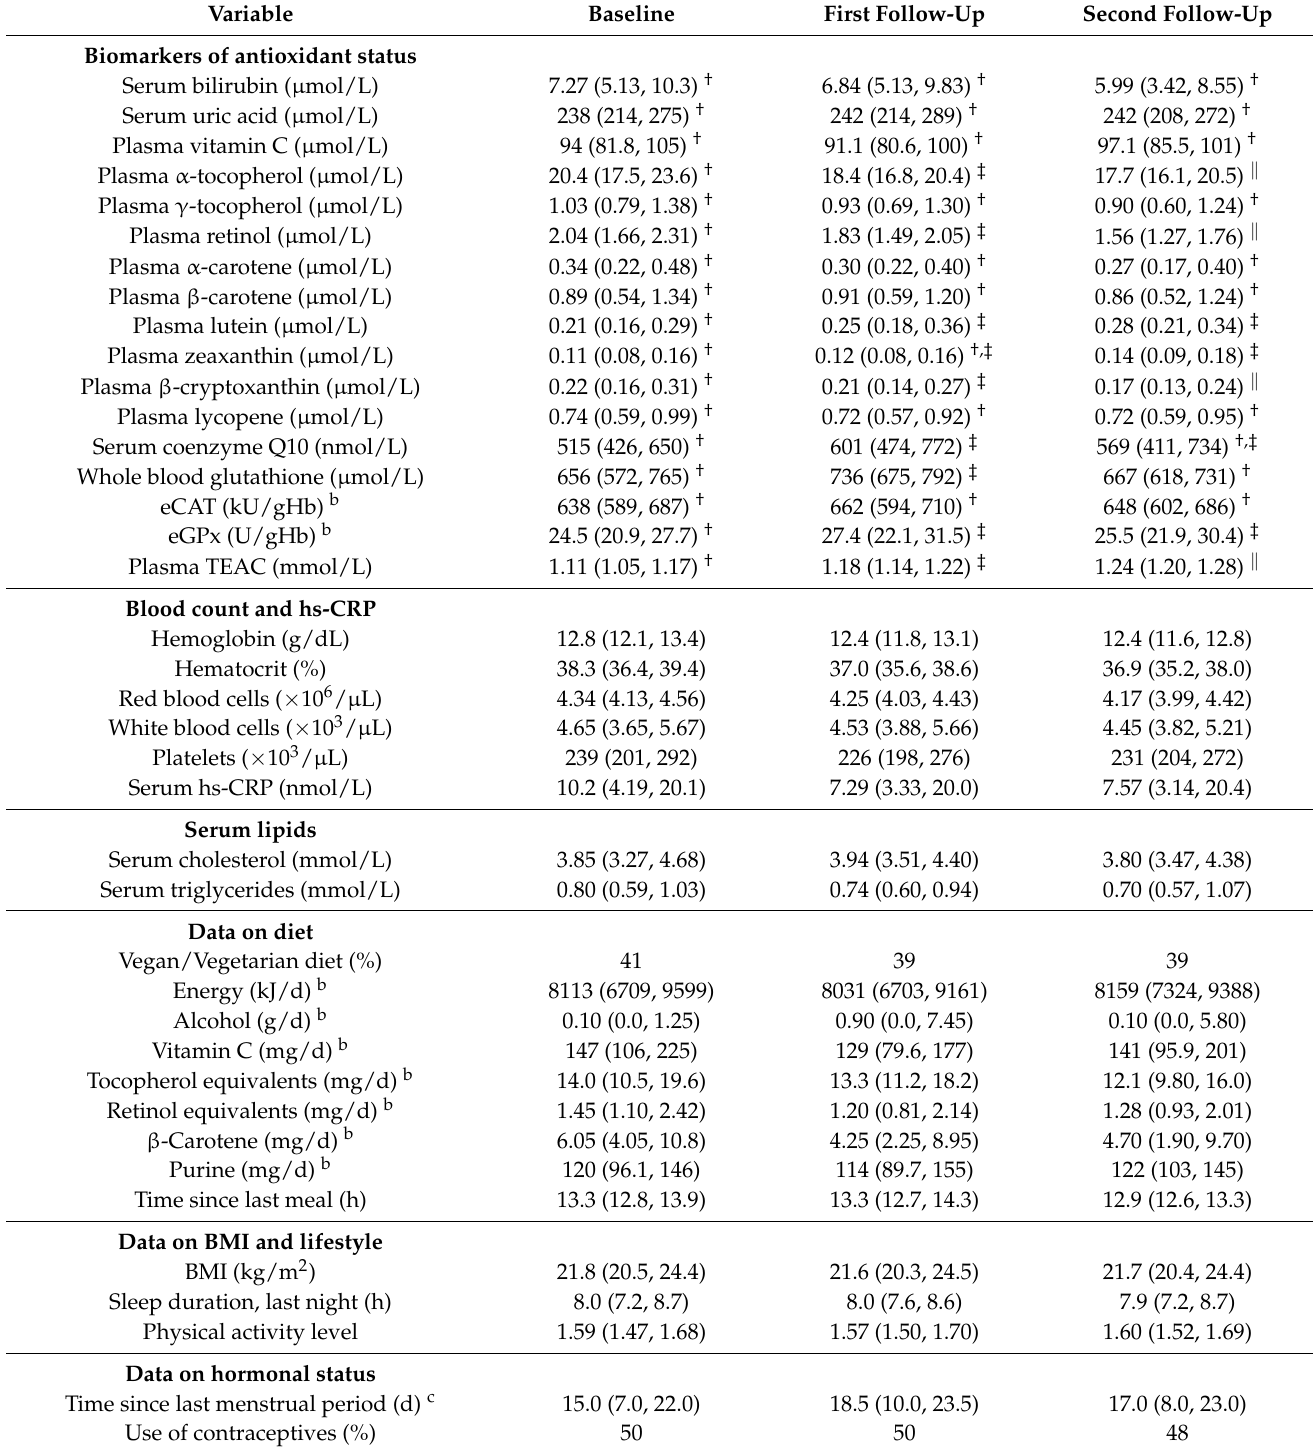
Table 1. Descriptive characteristics of the subjects at each measurement time point ( n = 44) a